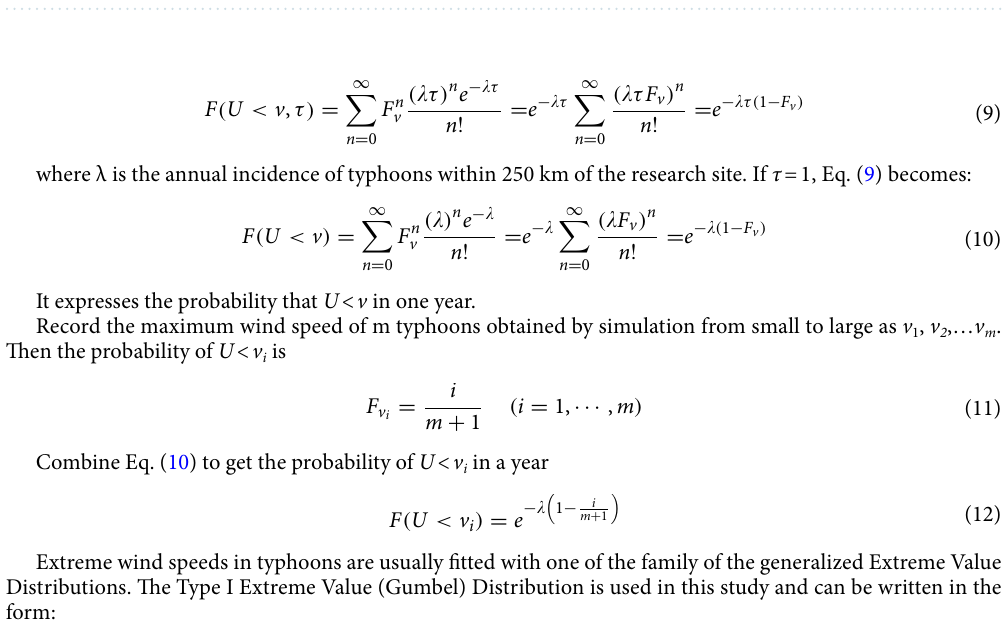
Table 1. Correlation coefficients among typhoon key parameters for historical typhoon wind